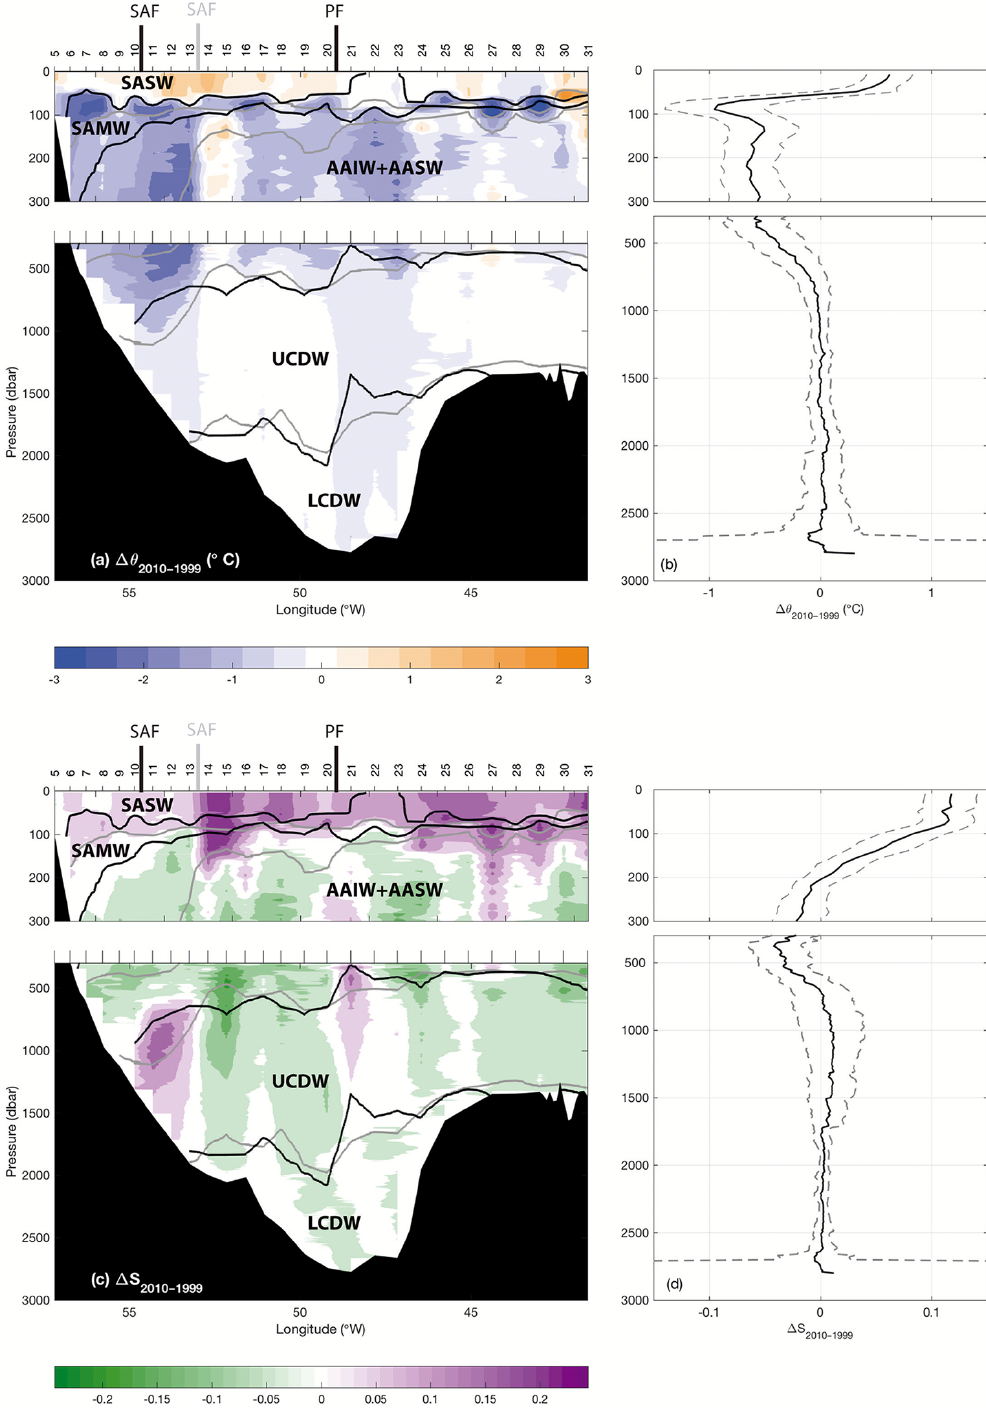
Figure 4. Vertical sections of differences in (a) potential temperature and (c) salinity in isobaric levels, for the 1999 and 2010 cruise. The lines superimposed over the vertical sections (grey lines for the 1999 section and black lines for the 2010 section) stand for the isoneutrals defining the different water masses in the region (26.90, 27.20, 27.60 and 28.00kgm − 3 ). MOC-Austral station numbering and the front (SAF (grey 1999, black 2010) and PF) locations are displayed on the top axis. Side panels show the zonally averaged differences in temperature (b) and salinity (d) , respectively (solid black lines), together with their 95% confidence interval based on a Student’s t -test (dashed grey